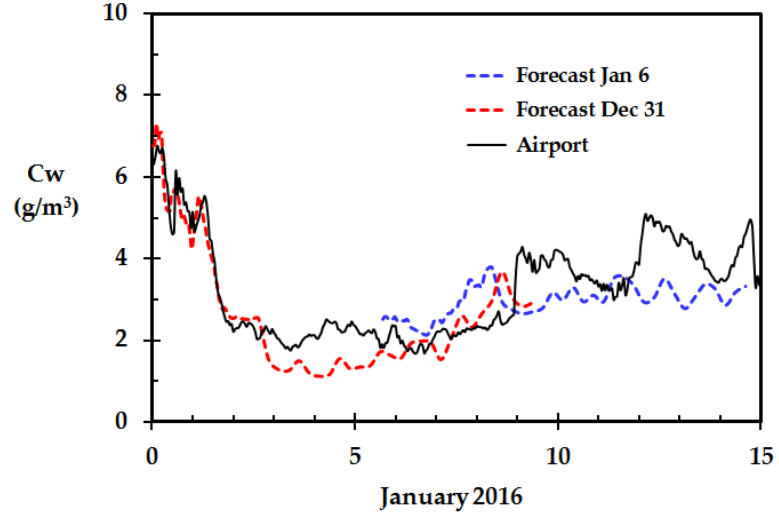
Figure 7. Calculated outdoor water concentration based on the forecasts at 31 December and 6 January and data subsequently retrieved from the meteorological station at Haugesund airport.